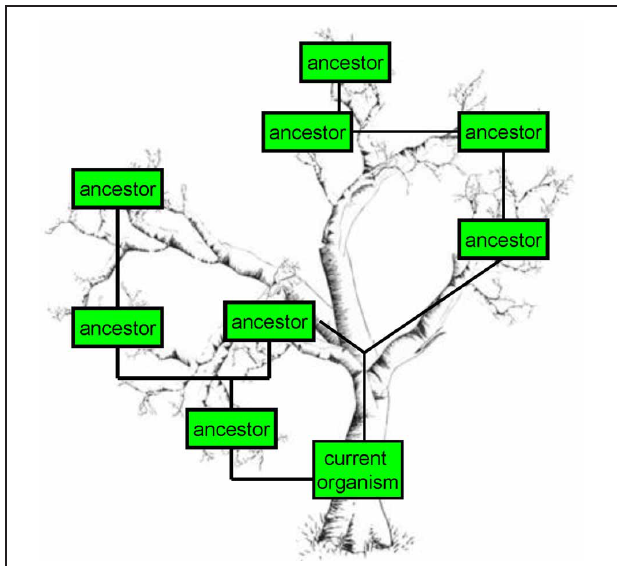
FIGURE 4 | Genealogic tree. A genealogic tree sample that harbors organisms with many ancestors closely or distantly related.